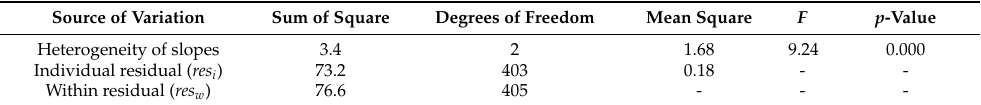
Table 13. Computation heterogeneity of slopes for cutting facilities based on chill casting.